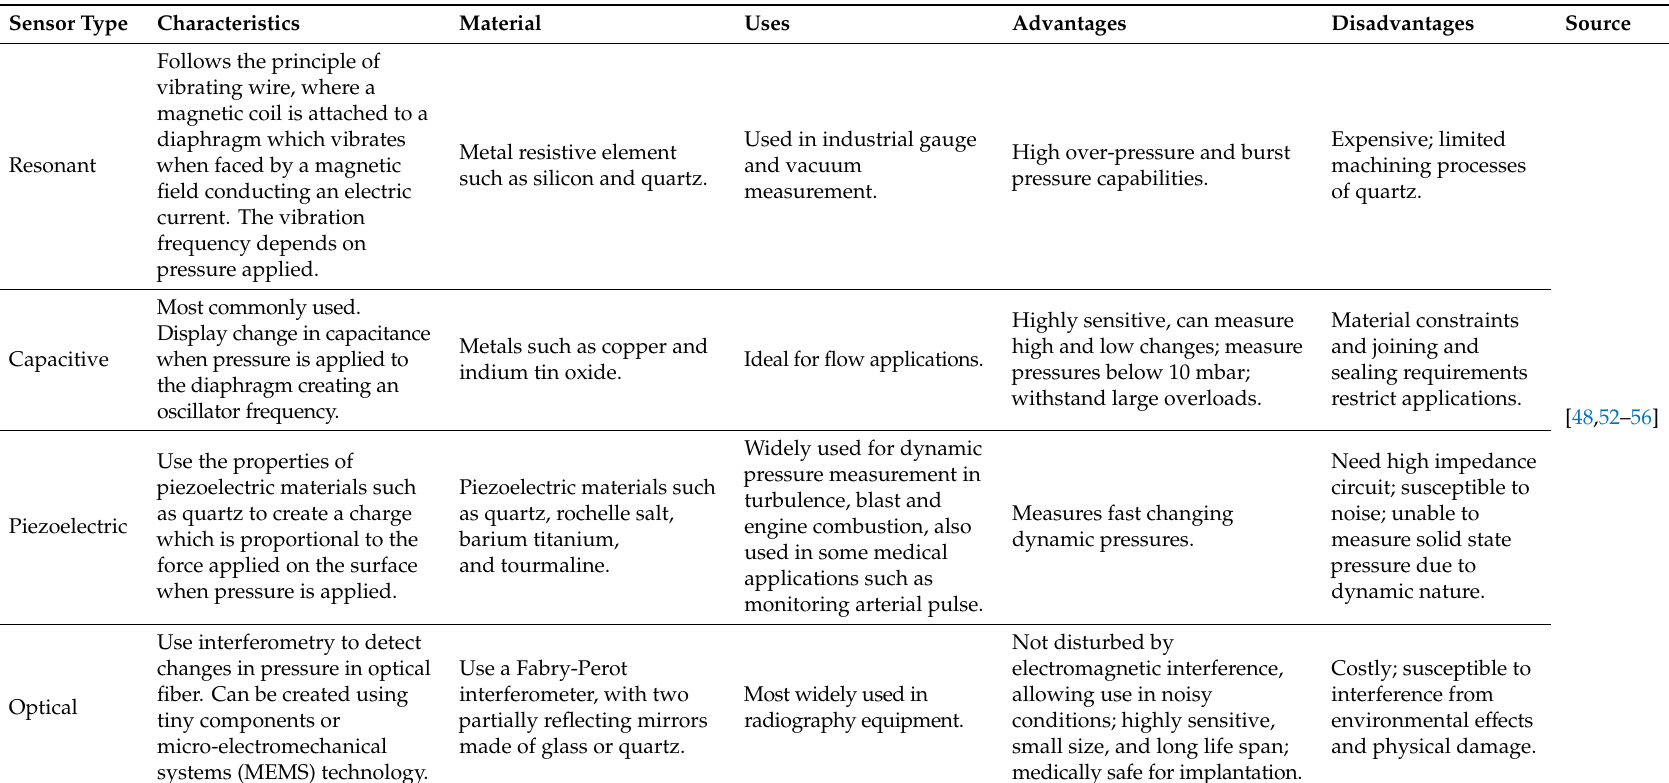
Table 3. Key features of pressure